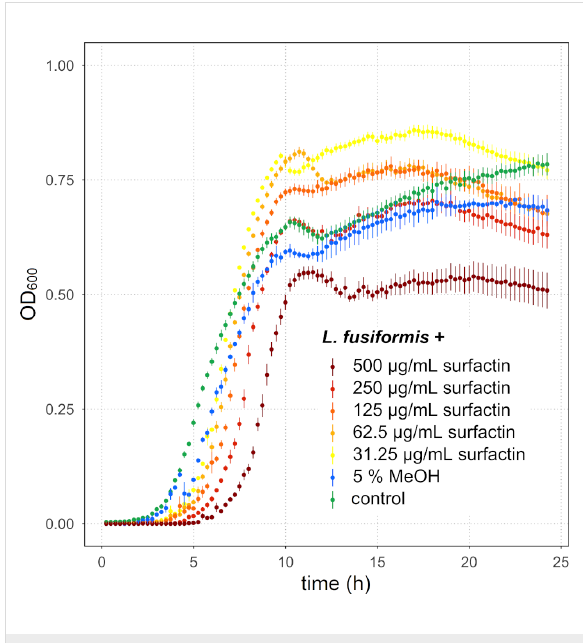
Figure 8: Growth curves of L. fusiformis M5 exposed to different con- centrations of surfactin, the highest concentration of the solvent MeOH, and without treatment (“control”). The error bars represent the stan- dard error. N ≥ 5 (control and surfactin-treated assays), N = 2 (MeOH- treated